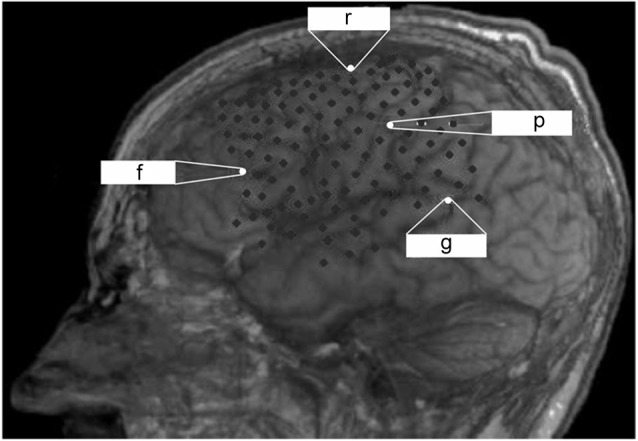
Lateral projections of implanted ECoG recording with a grid and two electrode strips resulting in a total of 128 contacts that cover a large part of the left hemisphere. Reference (r), ground (g) and recording channels on the frontal (f) and parietal (p) cortex for monitoring are indicated.